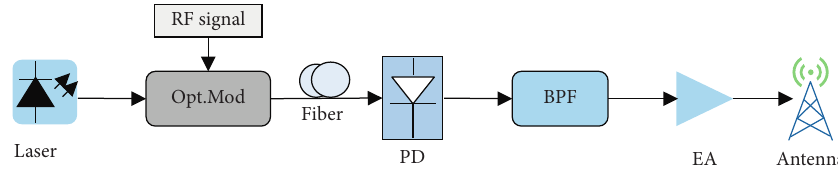
Figure 2: External modulation scheme structure diagram. Opt.Mod, optical modulator.